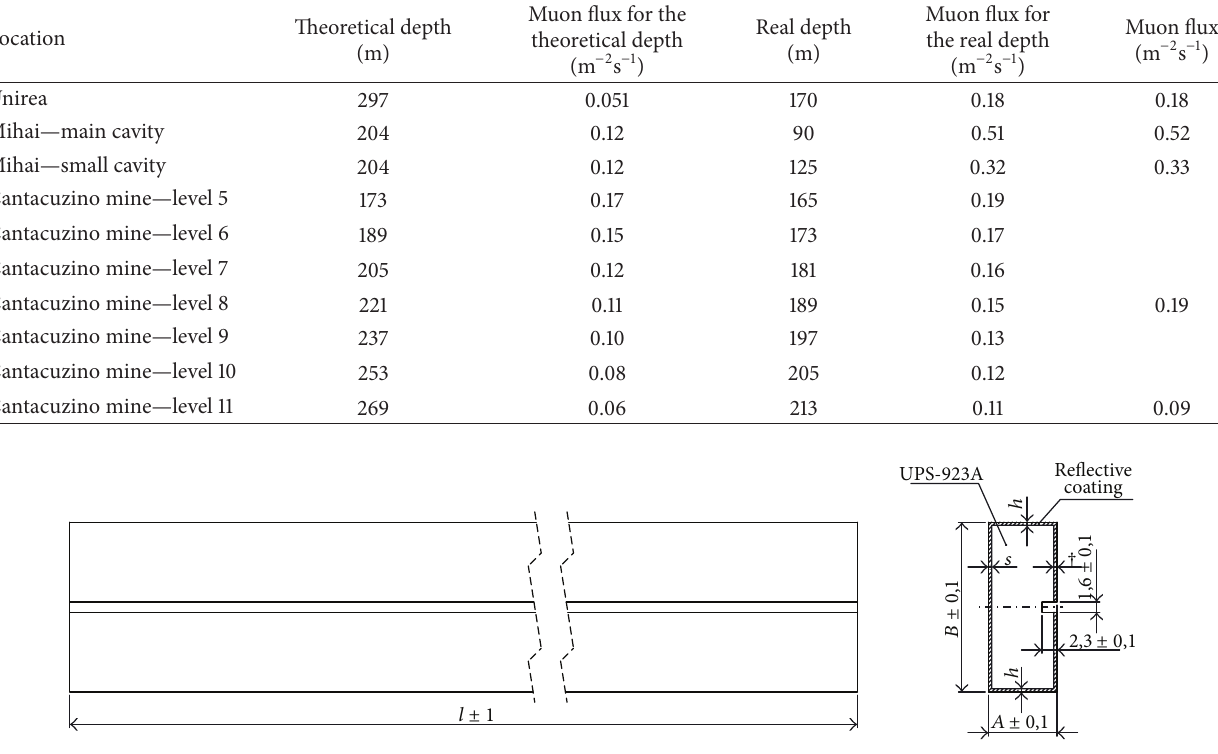
Table 1: The muon flux data obtained in underground measurements.